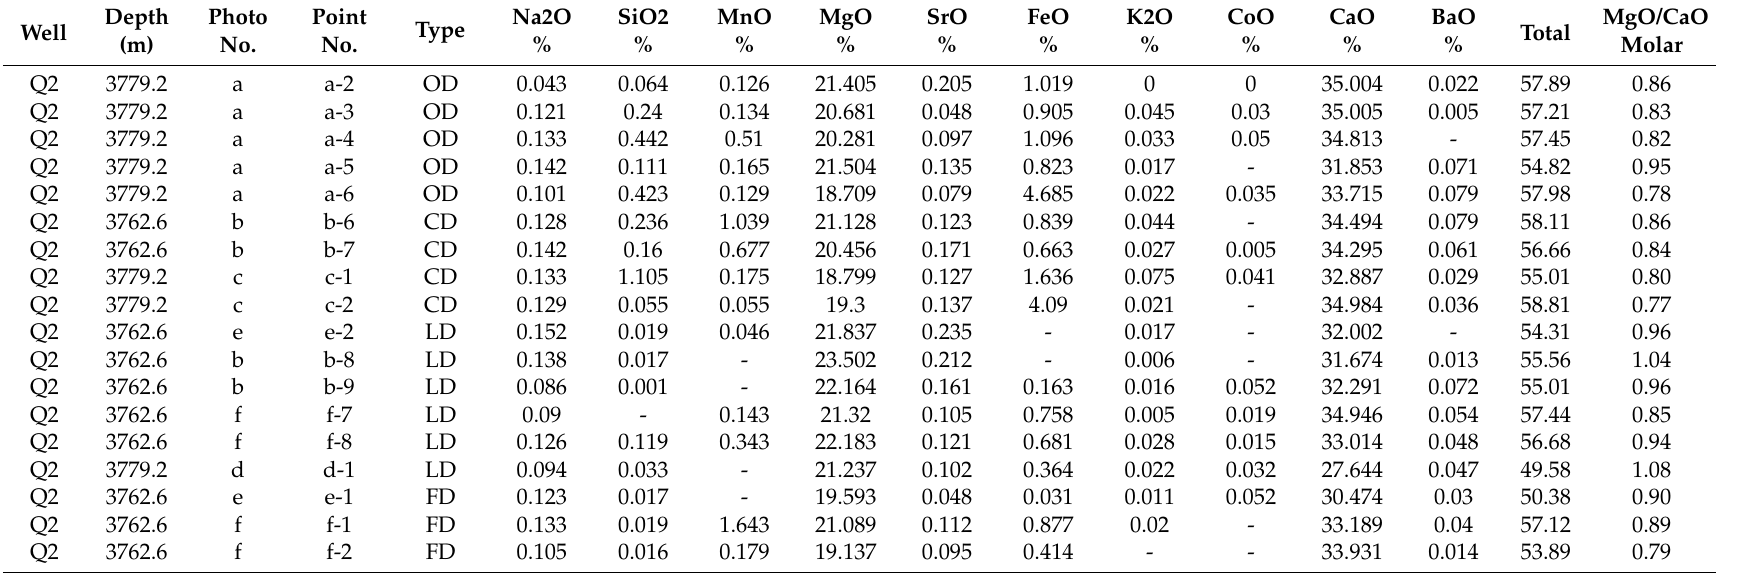
Table 3. Results of the geochemical analyses of different occurrences of